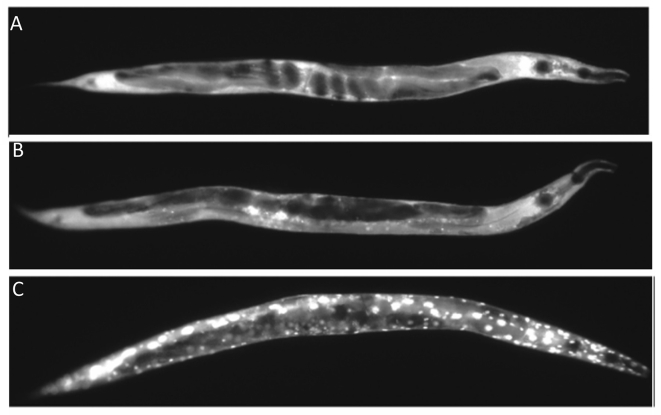
DAF-16::GFP induction categories. From top to bottom is the hypodermal translocation patterning associated with the A. low, B. medium and C. high categories referenced in Table 6.